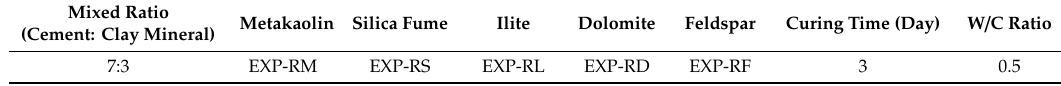
Table 3. Test conditions for reactivity of cement and silicate